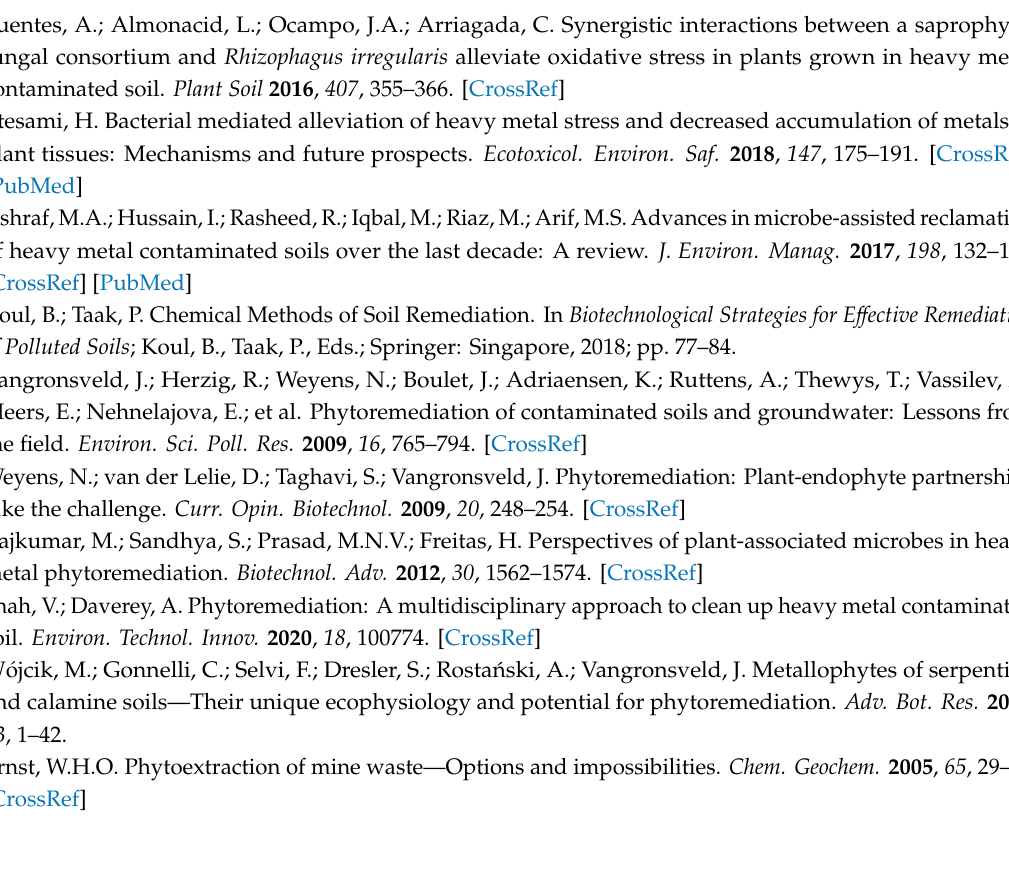
Table S1: Variable sites in 900-bp long fragments of 16S rRNA gene of Bacillus megaterium genotypes from the Zn–Pb rich waste heaps in Bolesław, Saturn, and Bukowno and the non-metalliferous reference area in Bolestraszyce; Table S2: Variable sites in 900-bp long fragments of 16S rRNA gene of Stenotrophomonas maltophilia genotypes from the Zn–Pb rich waste heaps in Bolesław, Saturn, and Bukowno and the non-metalliferous reference area in Bolestraszyce; Table S3: Potential plant-growth promoting traits of strains isolated from the endosphere tissues (i.e., roots, nodules, and leaves) and the rhizosphere soil of T. repens originating from the Bolesław, Saturn, and Bukowno waste heaps, and the non-metalliferous reference area in Bolestraszyce. Abbreviations: IAA—indole-3-acetic acid synthesis, sid—siderophores production, org acids—organic acids production, ACCD—deaminase ACC activity, acet—acetoin production, P solub—phosphorus solubilization, N-fix—atmospheric nitrogen fixation. Figure S1: Relative abundance of the cultivable strains displaying in vitro PGP abilities or metal tolerance (0.4 mM Cd, 0.6 mM Zn, 0.4 mM Cu), distributed over the di ff erent compartments, leaf endosphere, nodule, root endosphere and rhizosphere soil of T. repens ; Figure S2: Relative abundance of the cultivable strains grouped per PGP trait and metal tolerance (0.4 mM Cd, 0.6 mM Zn, 0.4 mM Cu) and shown per compartment of T. repens